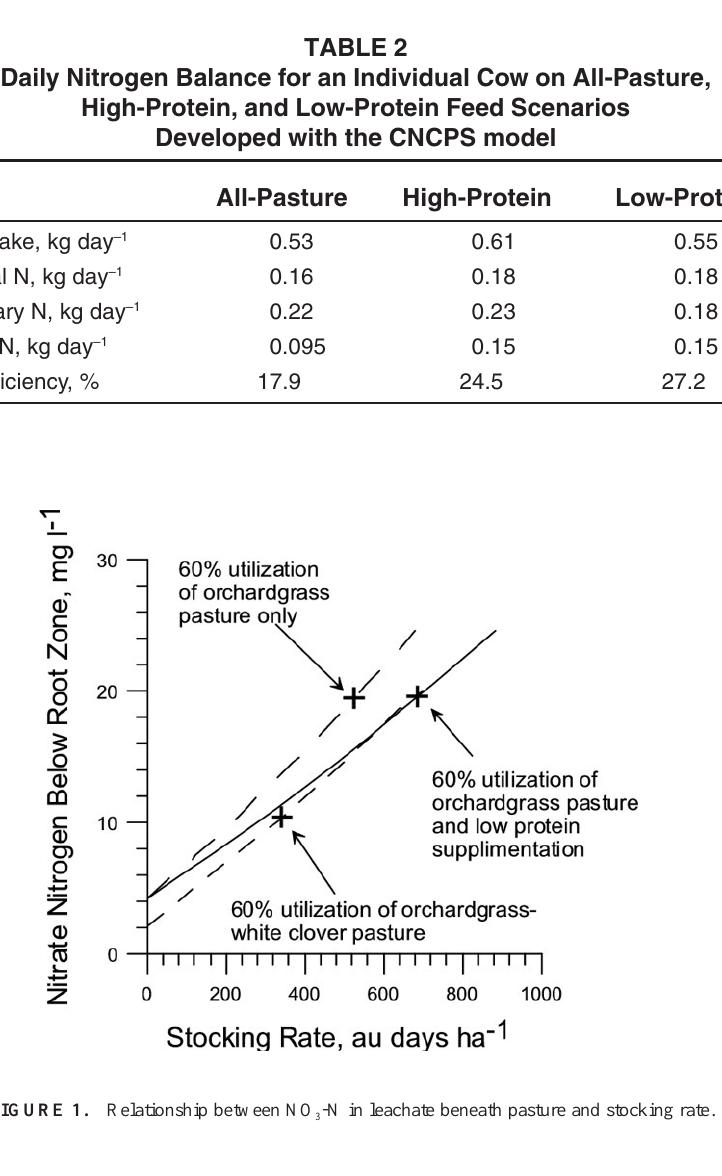
FIGURE 1. Relationship between NO